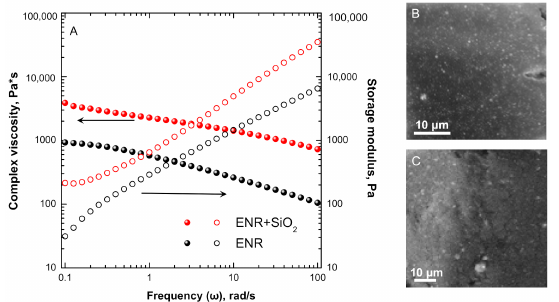
Figure 2. ( A ) Complex viscosity (full symbols) and storage modulus (empty symbols) and ( B , C ) SEM micrographs for ENR+SiO 2 composite at different